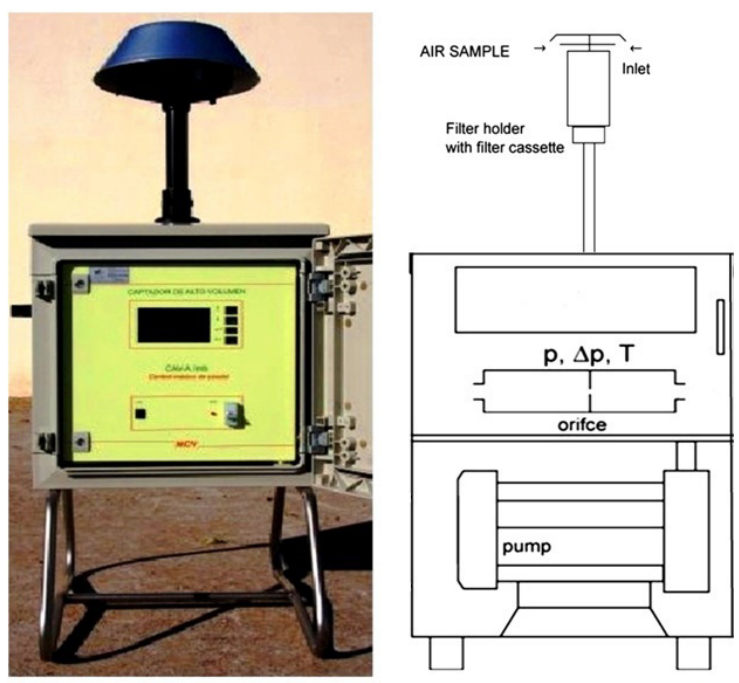
Figure 2. The main operating characteristics of the HVS captor used in the current